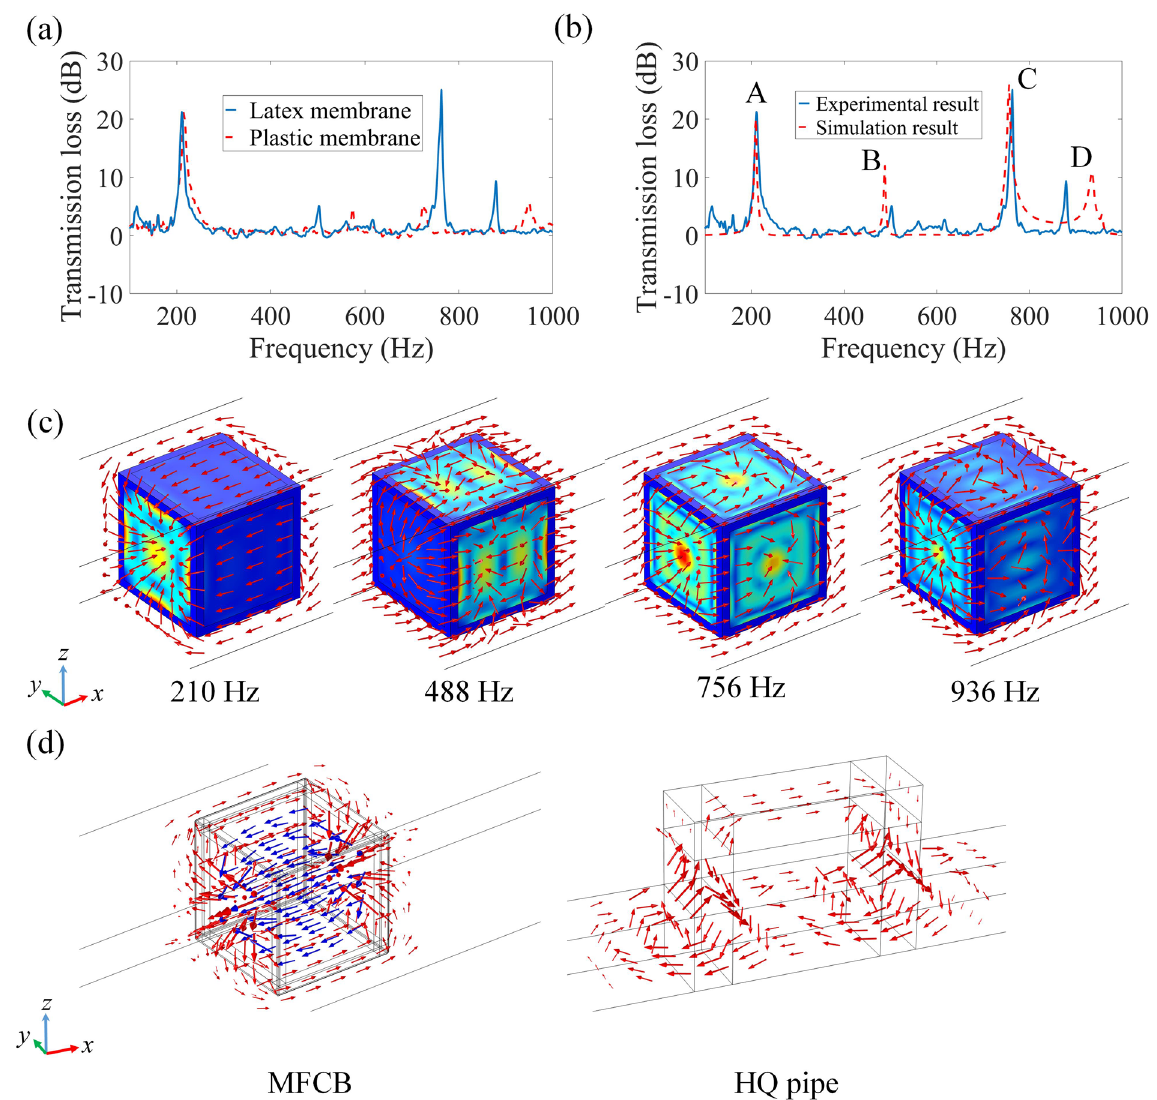
Figure 2. Transmission losses induced by the MFCB and the mechanism. ( a ) Measured transmission losses induced by the MFCBs created with two types of membranes, plastic and latex. ( b ) Comparison between the simulated and measured transmission losses induced by a MFCB based on latex membranes. ( c ) Vibration modes of the faces of the MFCB and acoustic intensities (red arrows) around the MFCB obtained at four sound attenuation peaks. ( d ) Comparison of acoustic intensities between the performance of a MFCB (Blue and red arrows indicate acoustic intensities in and around the MFCB, respectively.) and that of a HQ pipe (the figure is created using MATLAB 2016 and COMSOL